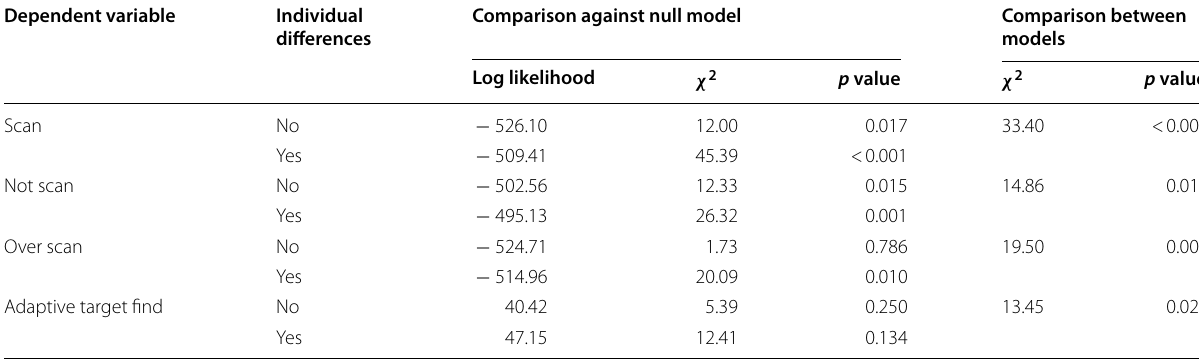
The following models were compared: 1 1 Group Group: Session + + respectively. Degrees of freedom for comparison between models were